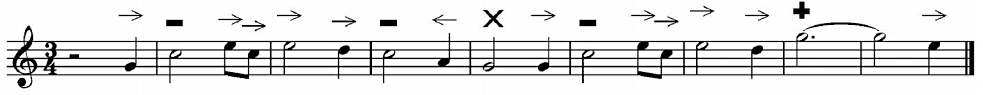
Figure 5. The first few measures of the melody of the popular tune Amazing Grace, showing a custom note-level prosodic labeling. Reprinted with permission from [32]. 2010, Taylor &